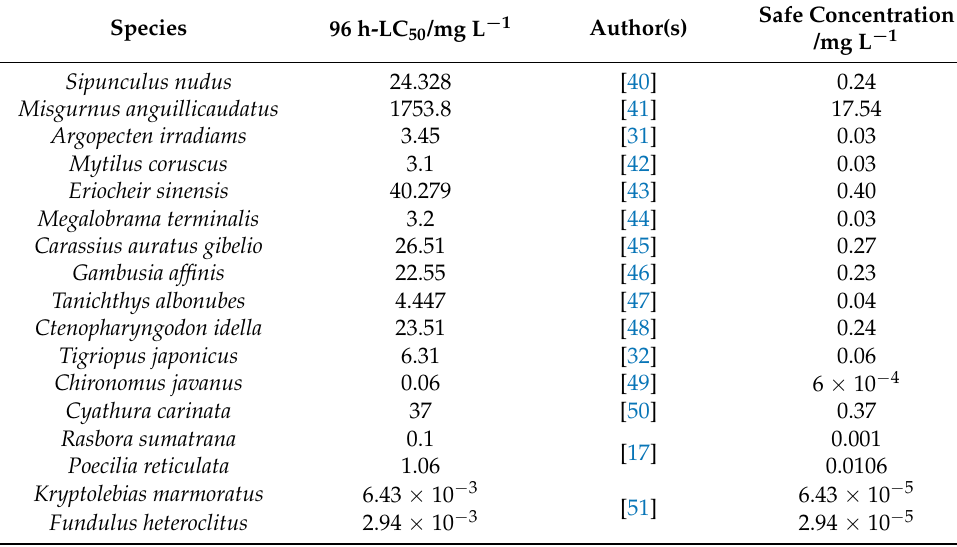
Table 6. The 96 h-LC 50 values of some common aquatic organisms in other